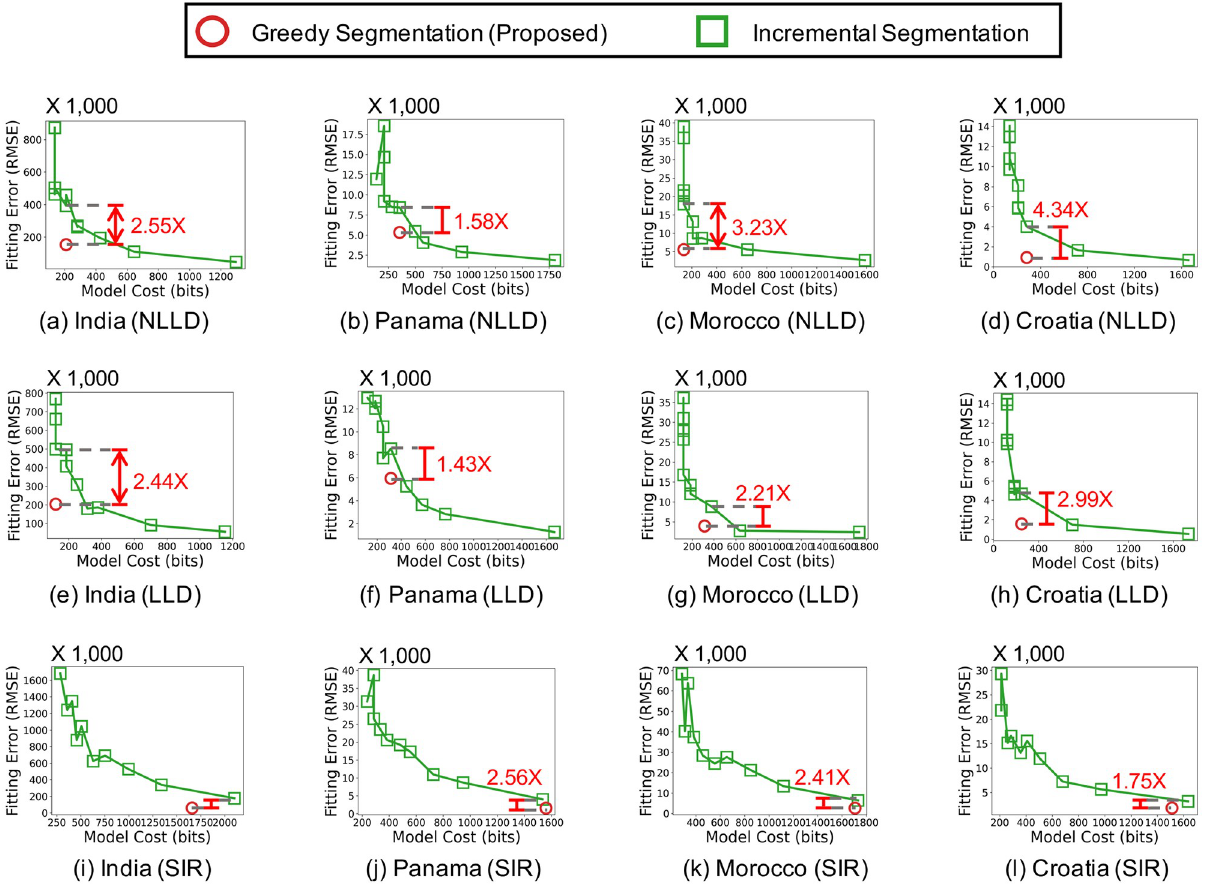
Fig 5. Our proposed greedy segmentation scheme based on the MDL principle yields better segmentation than the incremental method.